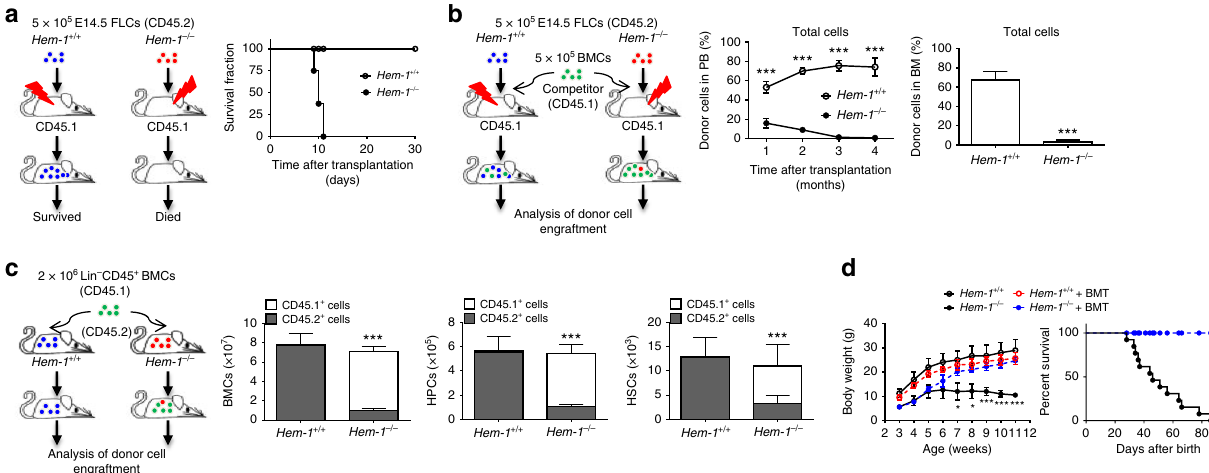
Fig. 2 Hem-1 deletion leads to an intrinsic functional defect in HSCs. a Schematic of rescue FLC transplantation where Hem-1 − / − CD45.2 HSCs failed to rescue lethally irradiated wild-type CD45.1 recipient mice ( n = 8, p < 0.001, log-rank test). b E14.5 Hem-1 − / − CD45.2 FL HSCs could not compete with recipient-derived CD45.1 BM cells (BMC) in repopulating lethally irradiated Hem-1 + / + adult recipient mice. Blood was analyzed monthly after transplantation and marrow at 4 months post transplantation ( n = 5, *** p < 0.001, Student ’ s t test). c Schematic of the competitive repopulation assay where exogenous littermate Hem-1 + / + CD45.1 HSCs ef fi ciently rehabilitated the hematopoietic system in Hem-1 − / − CD45.2 mice via a reverse stem cell transplantation assay in non-ablated mice. BMCs, HPCs, and HSCs were analyzed at 4 months post transplantation ( n = 8, *** p < 0.001, Student's t test). d Littermate Hem-1 + / + BM HSC rescued growth retardation and premature death when transplanted into non-ablated Hem-1 − / − mice ( n = 12, * p < 0.05, *** p < 0.001, body weight: two-way ANOVA; percentage survival: log-rank